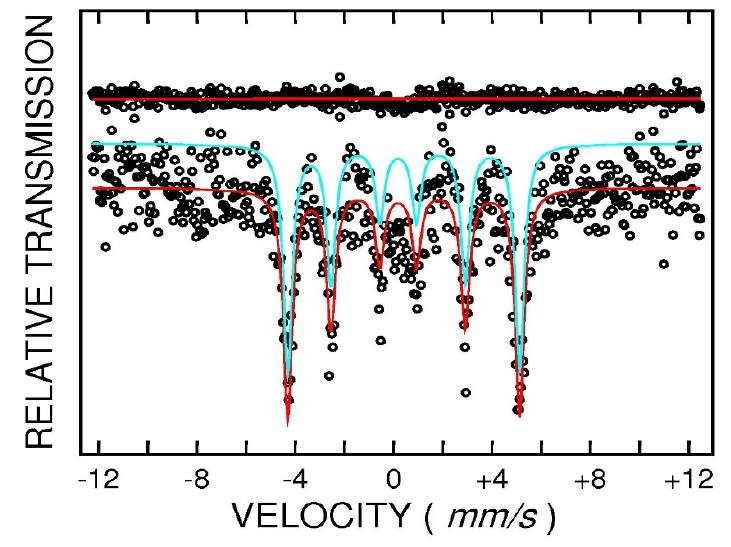
Figure 6. 57 Fe Mössbauer spectrum of the Fe 55 Pt 45 sample annealed at 400 °C.